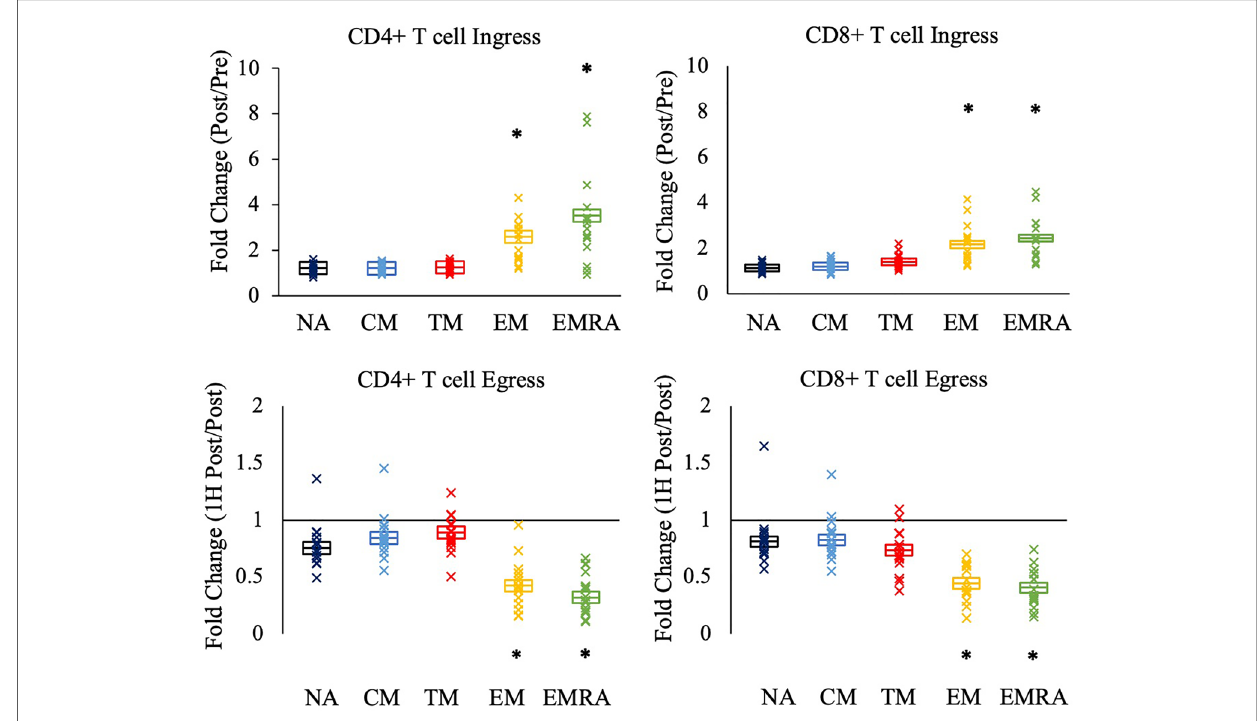
FIGURE 2 The relative mobilization of CD4+and CD8+ T-cell subsets by an acute bout of exercise. Ingress (upper panels) re fl ects the fold change in the concentration of cells post-exercise relative to pre-exercise, and egress (lower panels) re fl ects the fold change 1H post-exercise relative to post- exercise. Data are displayed as estimated marginal means (line) and standard error (box). Individual data points from each participant are also indicated (x). Statistically signi fi cant differences ( p <.05) in fold change from NA, CM, and TM is indicated by *. NA: naïve, CM: central memory, TM: transitional memory, EM: effector memory, EMRA: RA+effector memory.